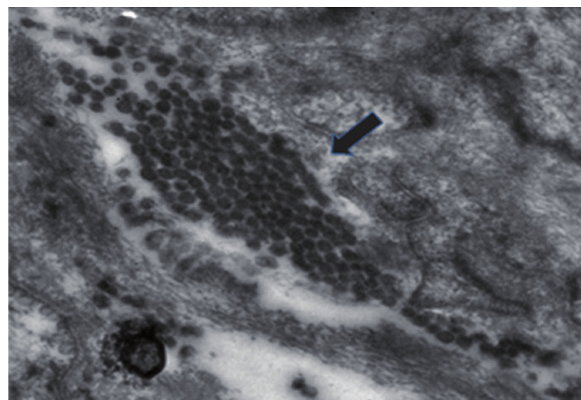
Figure 3 - Degenerative pattern (X-12800). Black arrow shows degenerative pattern.